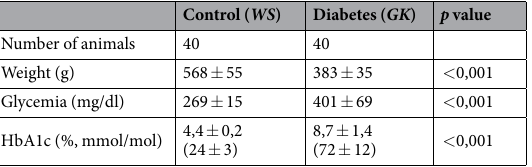
Table 1. Characteristics of the study animals. Data are mean ± SD; 12-month-old male type 2 diabetic Goto- Kakizaki (GK) and 12-month-old male Wistar (WS)